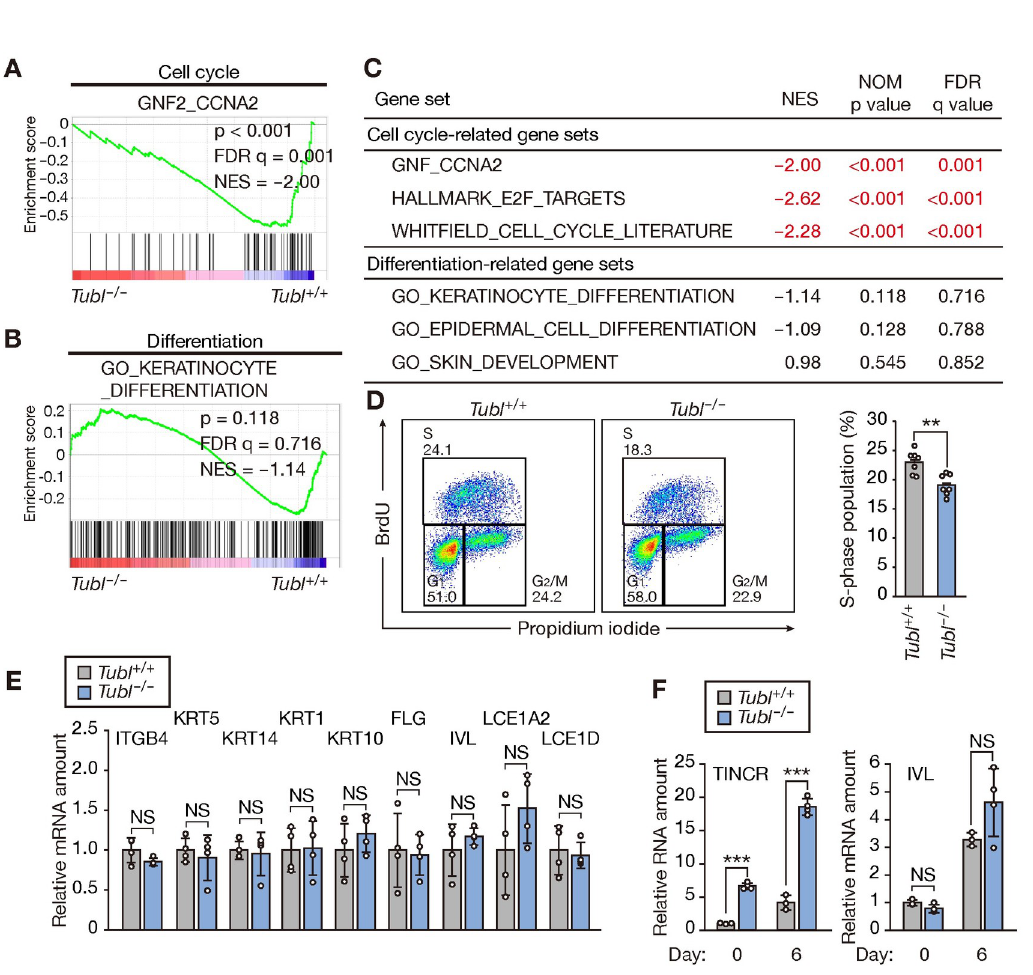
products were digested with EcoRI before electrophoresis. (D) RT-qPCR analysis of TINCR in the epidermis of Tubl +/+ and Tubl − / − mice. Data are means ± SD (n = 3 independent experiments). ��� p < 0.005 (Student’s t test). (E, F) Signal intensity of extracted ion chromatograms for mouse TUBL peptides in MRM analysis. The analysis detected two different peptides derived from mouse TUBL with the amino acid sequences AQLVGQGVSSWR (E) and DTLSDLR (F). “Standard” indicates an internal standard corresponding to stable isotope–labeled recombinant mouse TUBL. “Endogenous” indicates the endogenous TUBL peptides in epidermal lysates prepared from Tubl +/+ or Tubl − / − mice. Tryptic peptides derived from endogenous TUBL were mixed with tryptic peptides derived from the isotopically labeled recombinant protein and were then applied to MS analysis. Extracted ion chromatograms for each transition are shown in S1 Fig. (G) Hematoxylin-eosin staining of the skin of Tubl +/+ or Tubl − / − mice at 8 weeks of age. The boxed regions in the left panels of each set are shown at higher magnification in the right panels. Scale bars, 300 μ m.